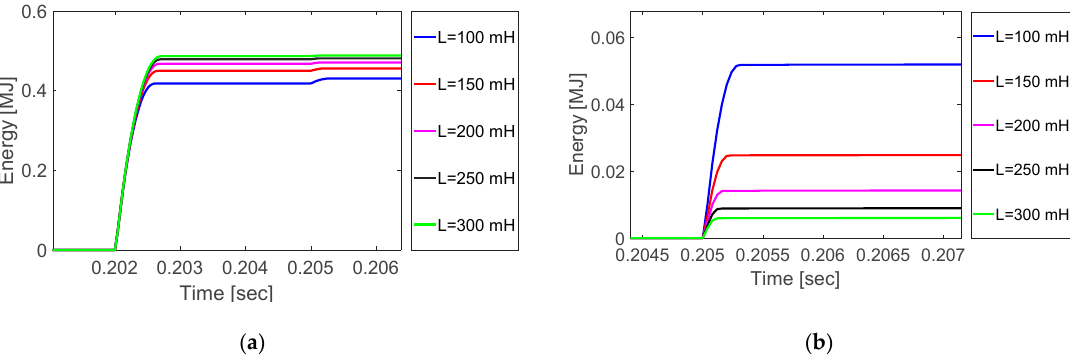
Figure 15. Energy absorbed by arrester under different values of L : ( a ) MOA ov ; ( b ) MOA m.